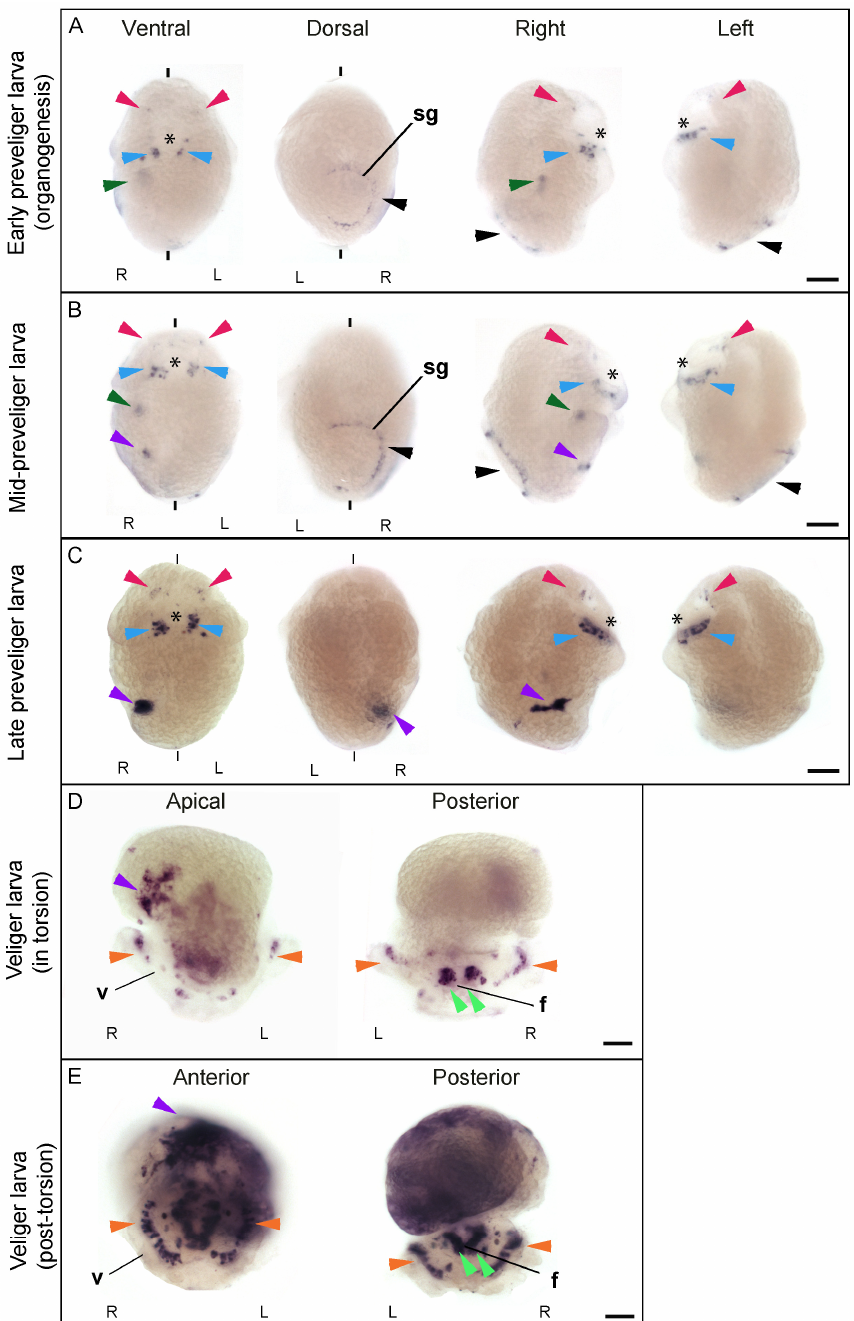
Figure 2. Spatiotemporal localization of Cfo- Nos expression in C. fornicata from preveliger to veliger larval stage. ( A – C ) show three sequential preveliger stages during development, respectively early (160 hpf), mid (170 hpf) and late (180 hpf). Preveliger larvae are shown in all four orientations, ventral, dorsal, right and left, to clarify interpretation of expression territories. ( D , E ) show two different veliger stages, torsion (190 hpf) and post-torsion (200 hpf) veliger larva stage, respectively. Panels D shows a larva in apical and posterior view, and panel E in anterior and posterior views. The asterisk shows the stomodeum. Arrowheads indicate: red, cephalic signals with apical and cerebral ganglions; light-blue, blastoporal nerve cord signals; black, shell gland signal; dark-green, right upper signal; purple, right lower signal; orange, sensorial organs at the velum; light-green, foot and catecolaminergic signals. f, foot; sg, shell gland; v, velum; R, right; L, left. The scale bar is indicated for each developmental stage and corresponds to 30 μ m.